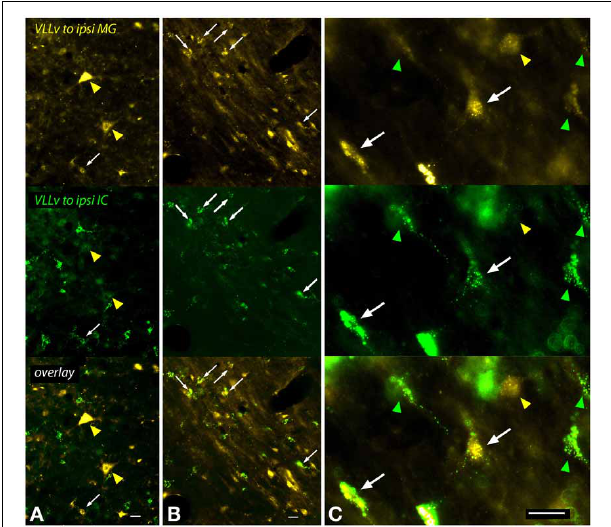
FIGURE 9 | Photomicrographs showing labeled cells in the left ventral subdivision of the ventral nucleus of the lateral lemniscus (VLLv) after injections into the left medial geniculate nucleus (MG) and the left inferiorcolliculus(IC)(GP597). Eachpanelisdividedintothirds,withthetop part showing FluoroGold label, the middle part showing green bead label and the bottom part showing an overlay of the two images. (A,B) Low magnification images to show both the large number of labeled cells and the range of sizes of the labeled cell bodies. Double-labeled cells were present (white arrowheads), but did not include the largest cells, which were labeled onlybyFluoroGold(yellowarrowheadsin A ). (C) Highermagnificationimages toshowdouble-labeledcells(whitearrows)interspersedamongcellslabeled with only FluoroGold (yellow arrowhead) or green beads (green arrowheads). Thedouble-labeledcellsaremultipolarcells,onewithamultipolarsoma(right arrow) and one with an elongate soma (left arrow). The FG-only cell (yellow arrowhead) has a round soma and may be a globular or multipolar cell. Scale bar = 20 µ m. All panels: transverse sections; dorsal is up; lateral is to the left. Abbreviations: ipsi, ipsilateral.